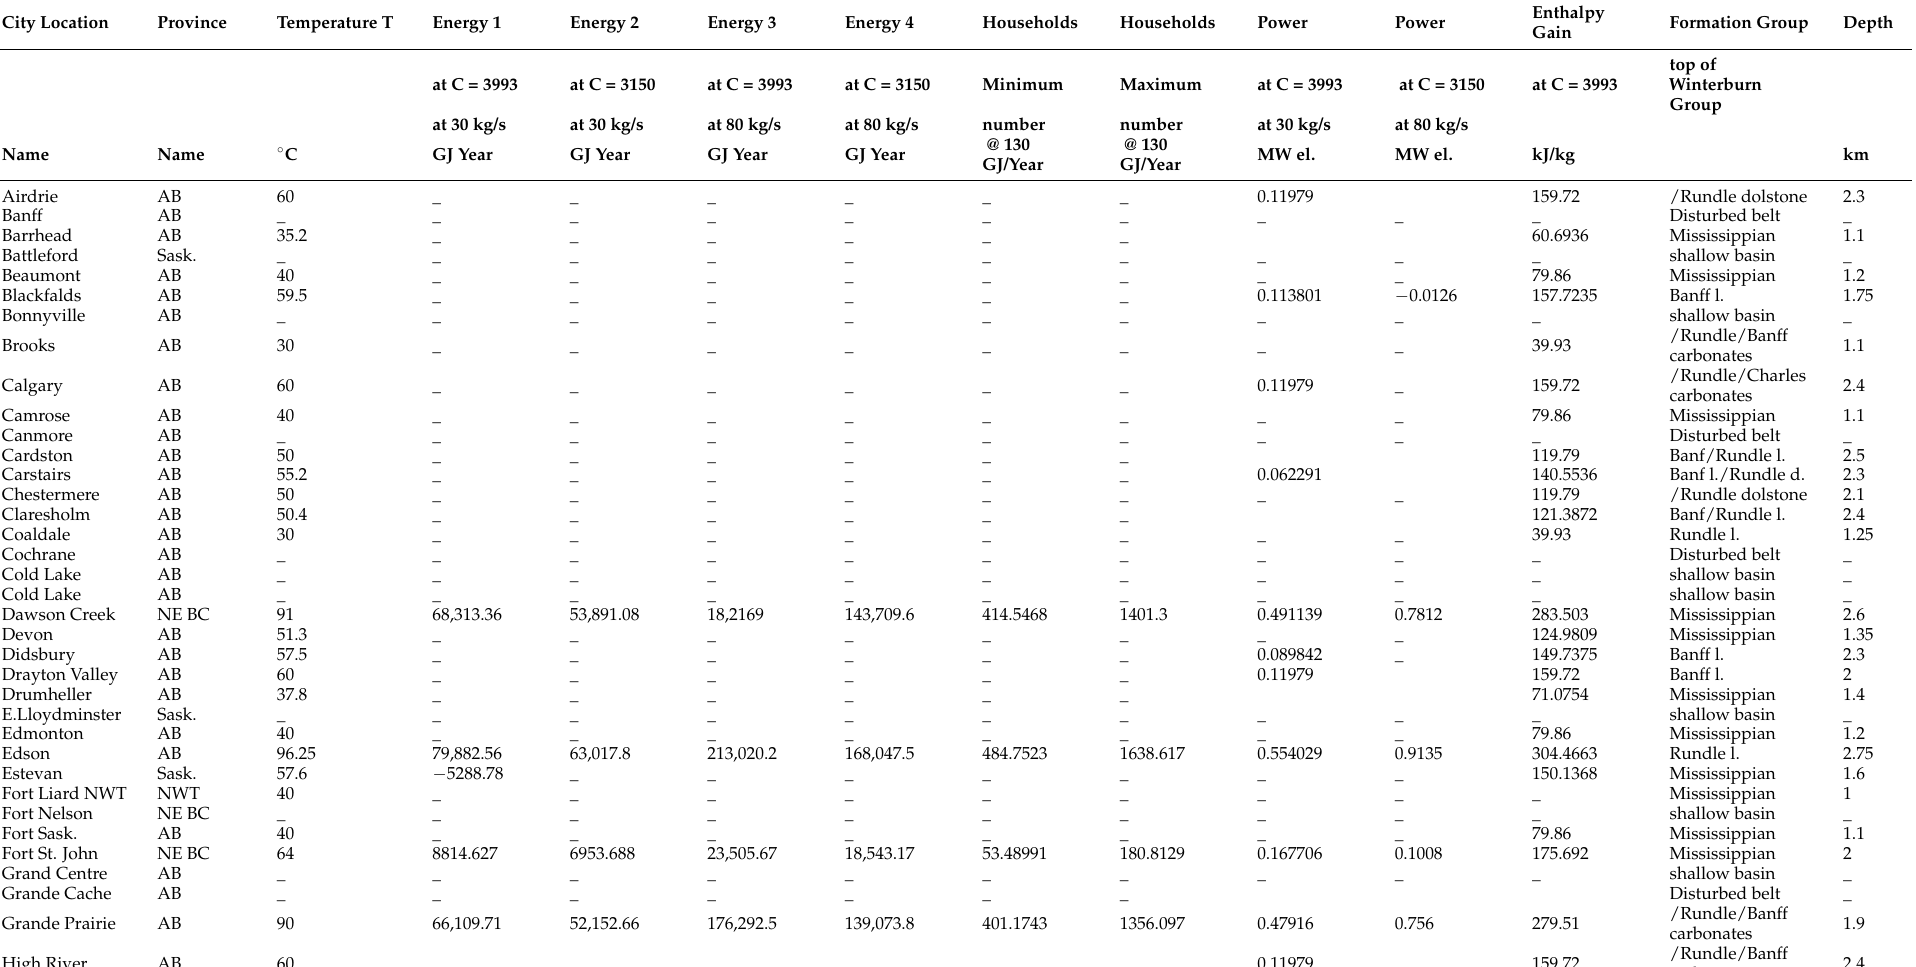
Table A4. WCSB >3 k populations centers geothermal prospects summary—Mississippian Groups—-Energy, Enthalpy, Power, Number of direct deep geothermal energy heated households